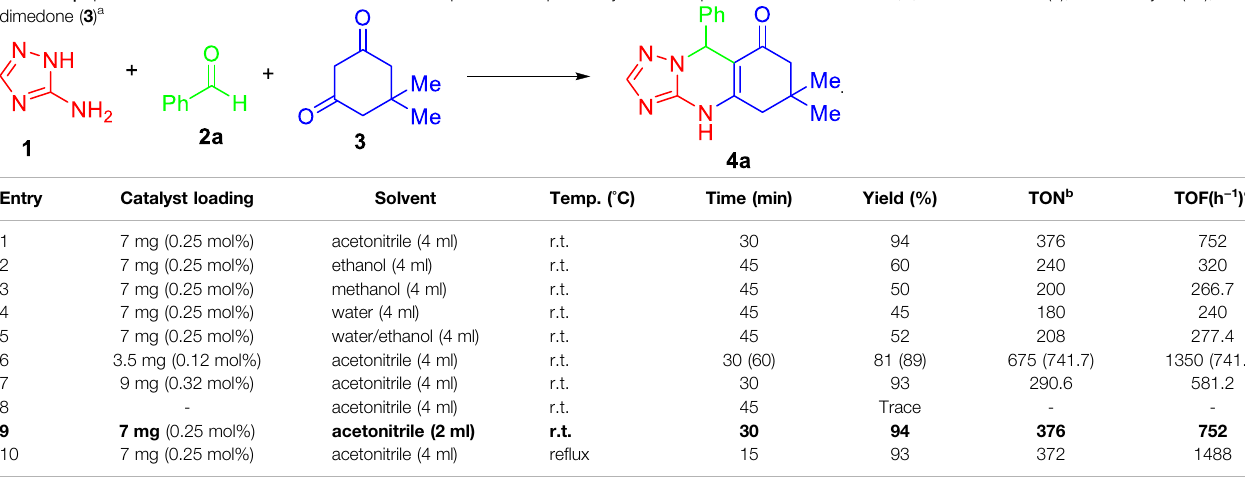
TABLE 1 | Optimization of the reaction conditions for the one-pot multicomponent synthesis of quinazolinone 4a from 1 H -1,2,4-triazol-3-amine ( 1 ), benzaldehyde ( 2a ), and dimedone ( 3 ) a